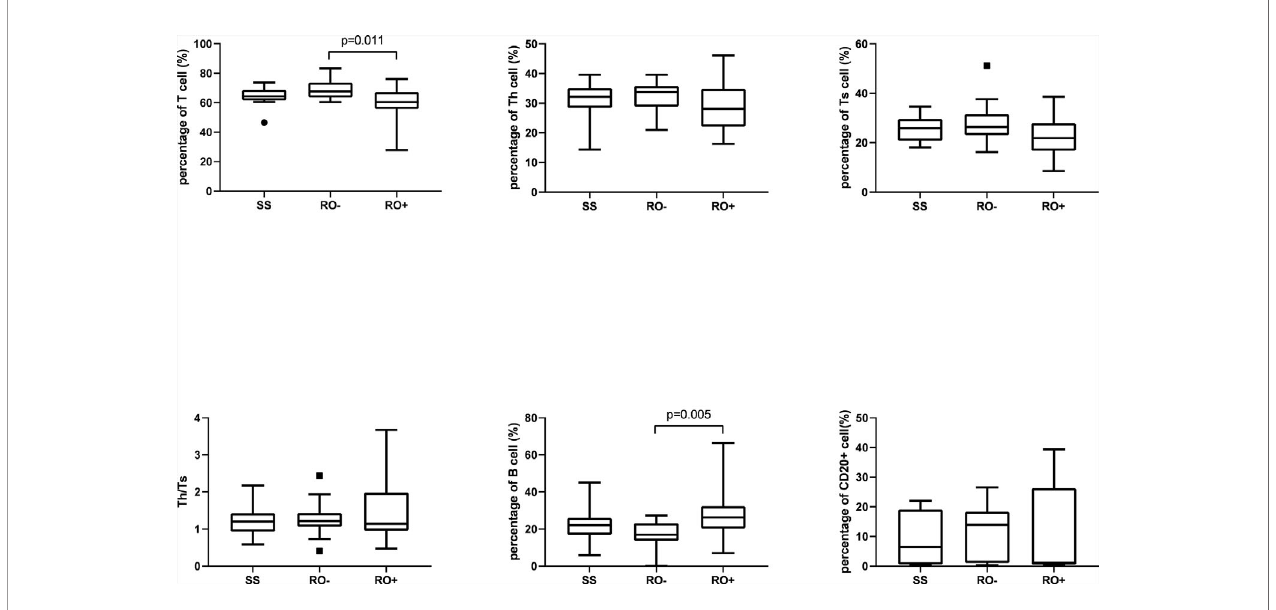
FIGURE 1 | The serum level of in fl ammatory cytokines in disease classi fi cation.